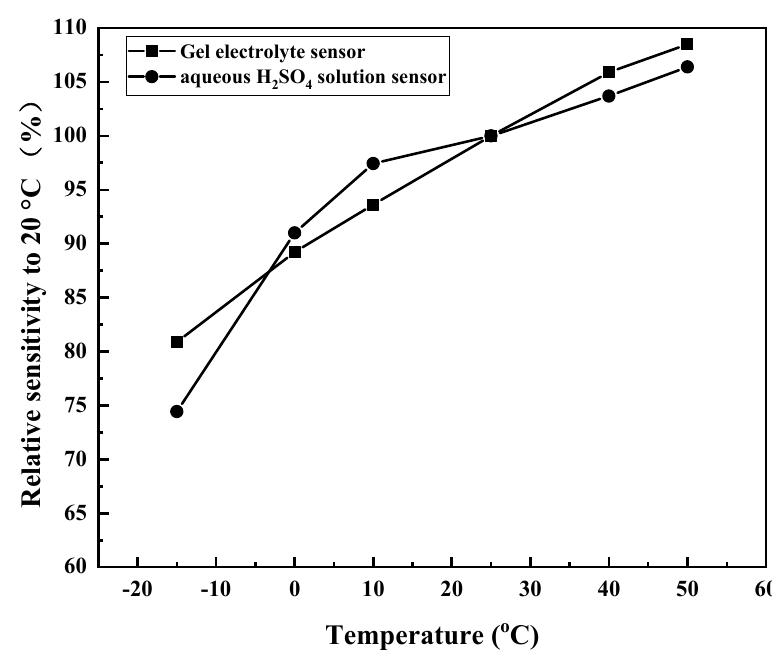
Figure 12. Influence of ambient temperature on the relative sensitivity of the two sensors.